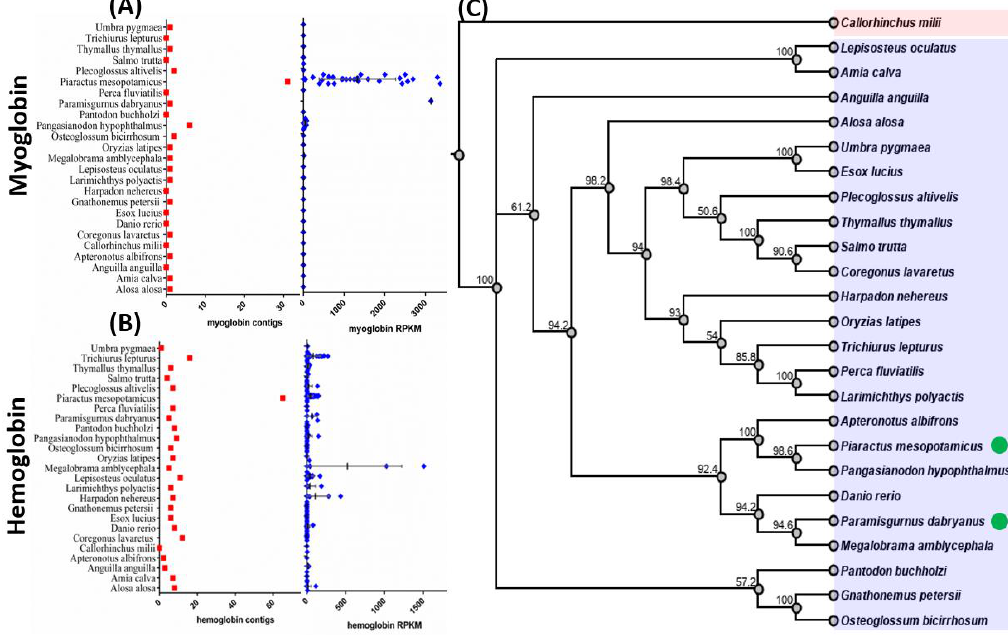
Figure 2. The assembled contig number and relative expression levels of myoglobin and hemoglobin of 25 diverse fish species. ( A ) The gene contig number (red color) and expression level (blue color) comparison for myoglobin in fish. ( B ) The gene contig number (red color) and expression level (blue color) comparison for hemoglobin in fish. The gene expression level was normalized and compared by Reads per Kilobase Million (RPKM) values. ( C ) The phylogenetic tree based on complete mitochondrial DNA sequences from 25 fish species. The multiple sequence alignment and phylogenetic tree construction were performed by Geneious software and bootstrap value, to support the tree topology, and are indicated in the root position of each branch. The red- and blue-shaded color column represents cartilaginous and teleost lineages, respectively. The green dots represent two fish species that were identified with high myoglobin expression in the skeletal muscle.